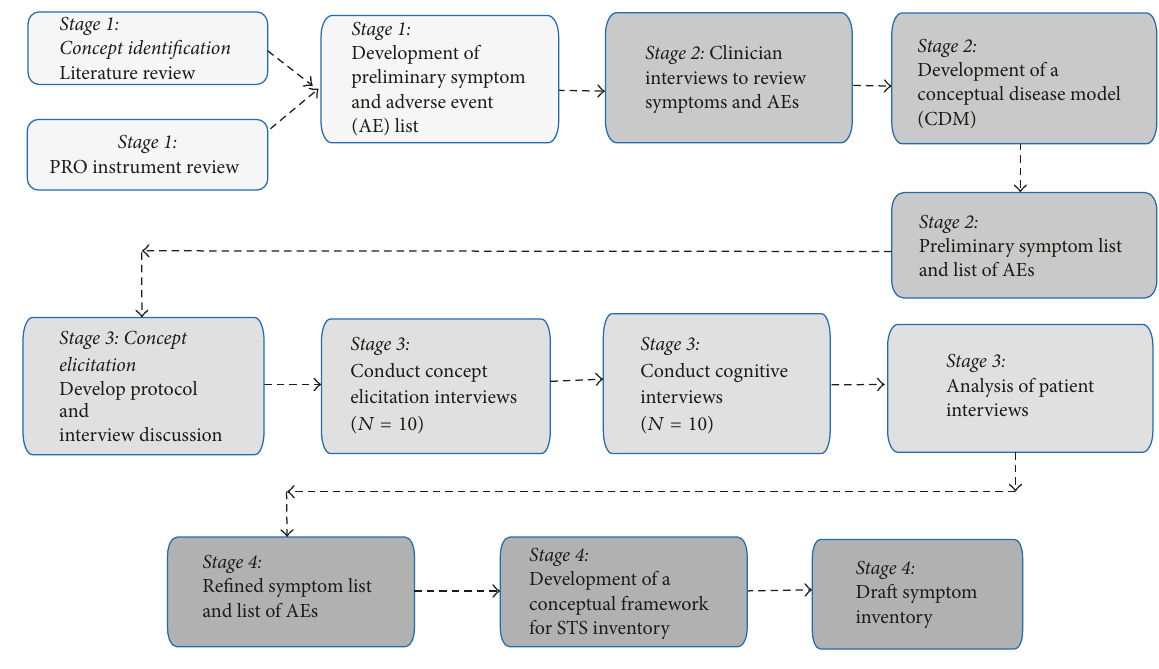
Figure 1: Overview of study